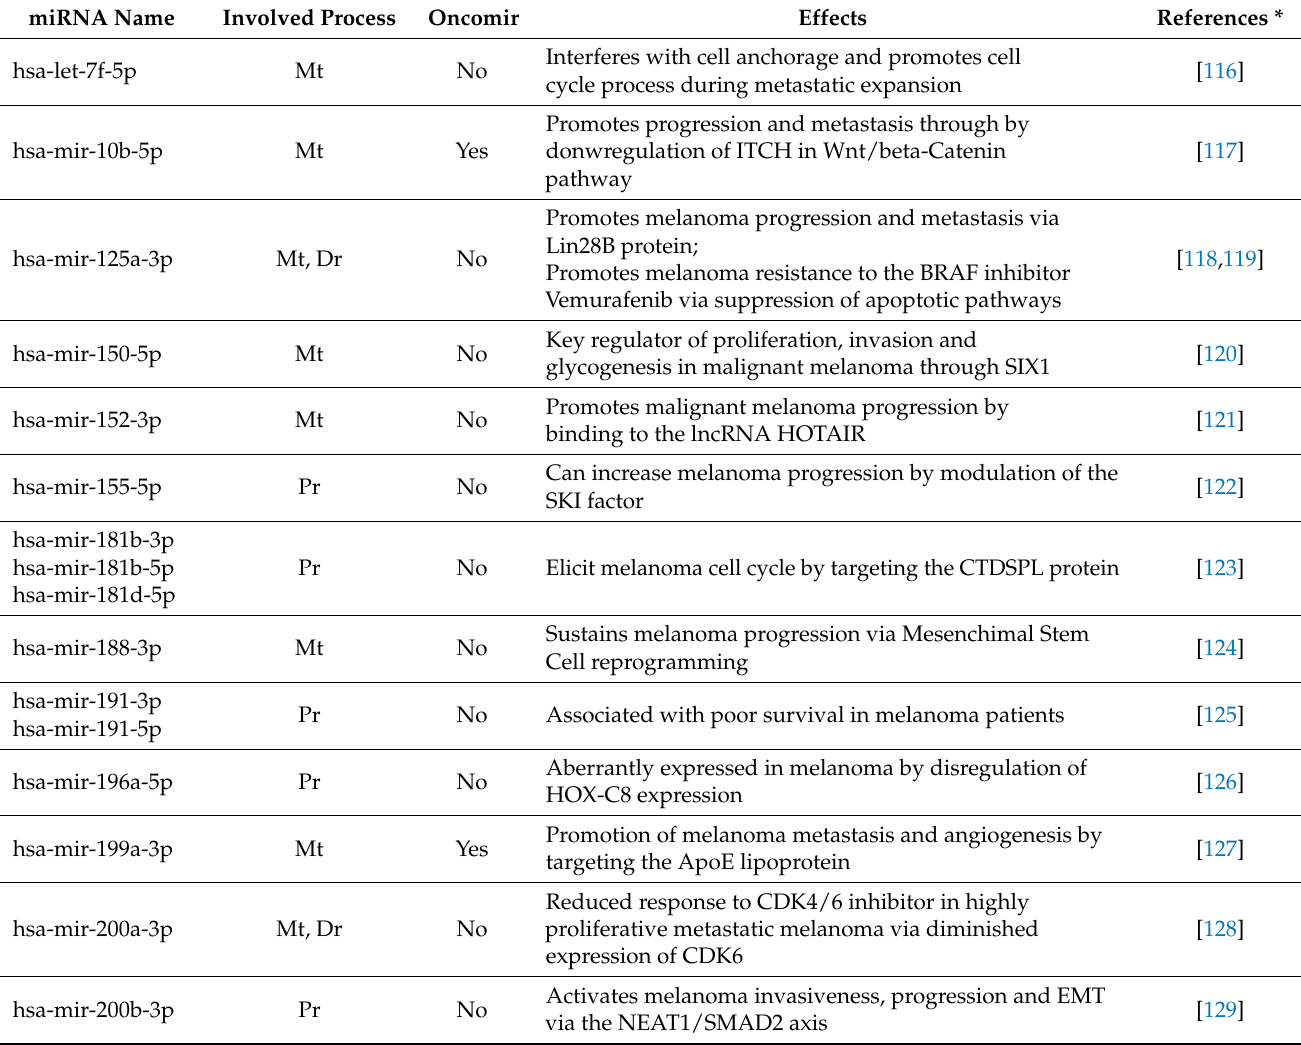
Table 2. Effects of hypoxic miRNAs listed in Figure 1 (red arrowheads) on melanoma progression, metastasis, and therapy resistance. Mt, Metastatic expansion; Pr, Proliferation; Is, Immunosuppression; Dr, Drug resistance; EMT, Epithelial to Mesenchimal Transition; * Refer to Supplementary Materials for the specific reference